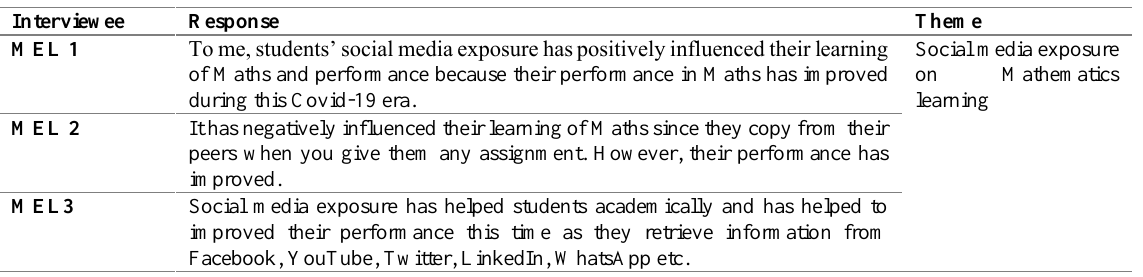
Table 4: Question 4 - What is the impact of social media exposure on your students’ learning of Mathematics and performance in